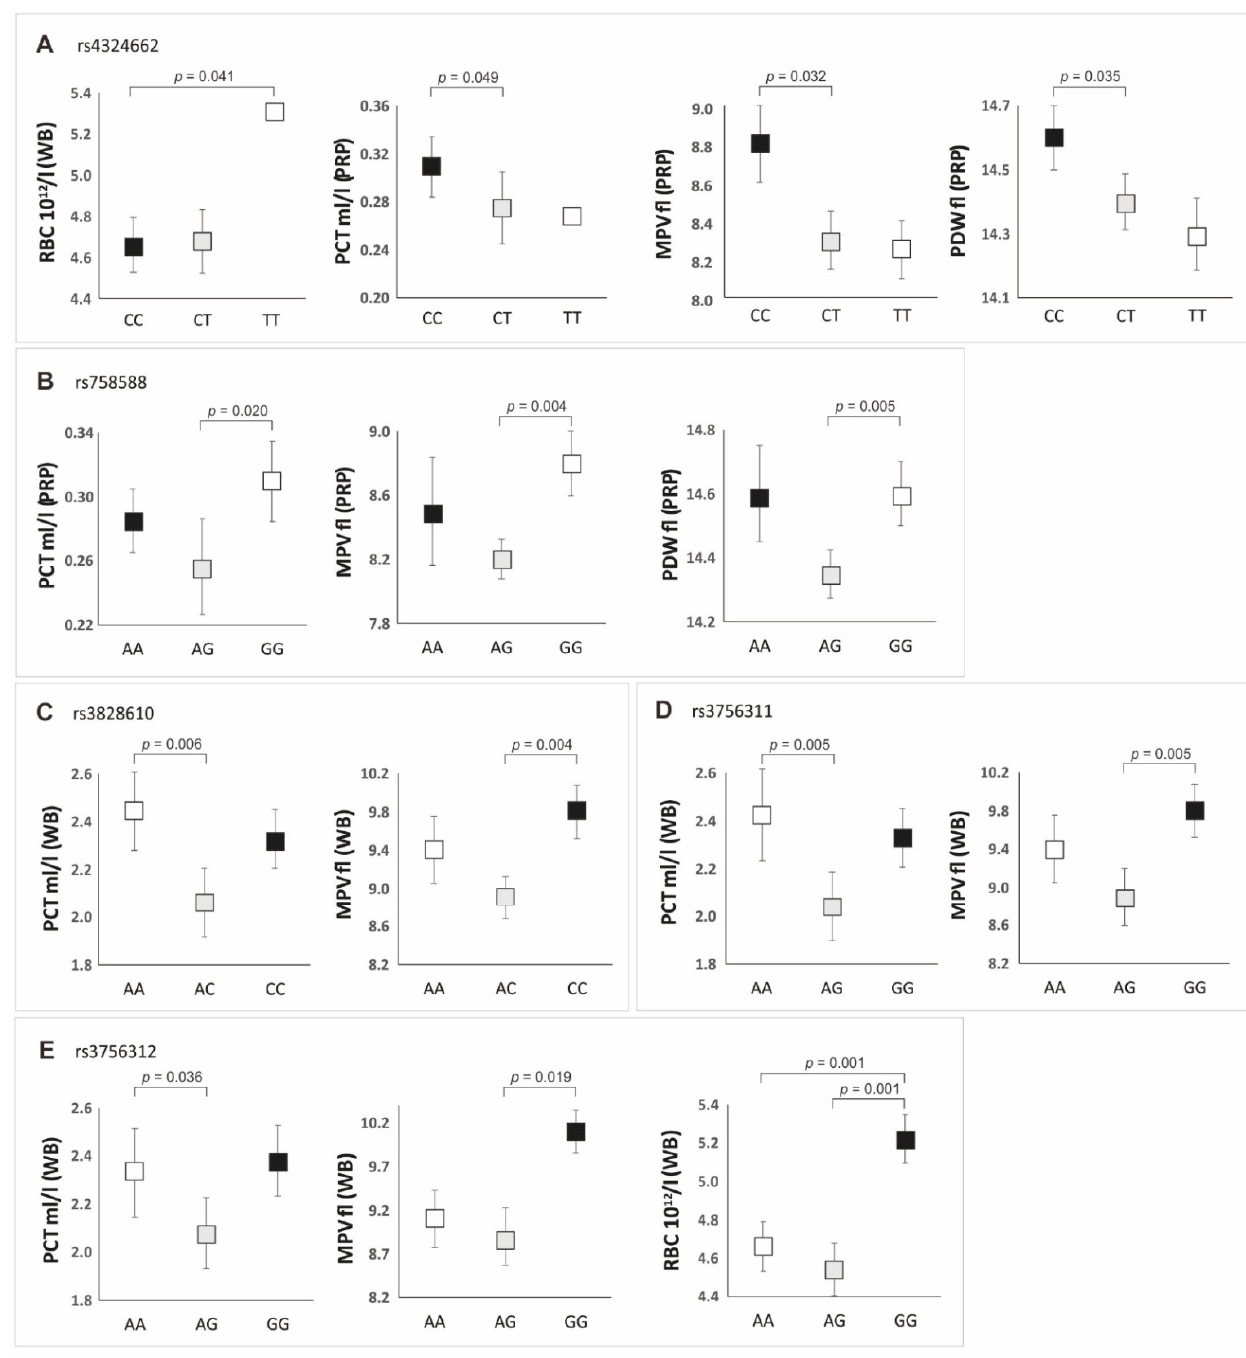
Figure 3. Whole blood (WB) and platelet-rich plasma (PRP) parameter values in individuals with particular genotypes of PDGFRB gene polymorphisms (additive model): ( A ) for rs4324662; ( B ) for rs758588; ( C ) for rs3828610; ( D ) for rs3756311; ( E ) for rs3756312 SNP. The factor that significantly differentiated particular genotypes ( p < 0.050) was, how- ever, the number of alcohol units consumed per week (Table S1). The most alcohol units were consumed by the cases with the genotype TT (rs4324662), AA (rs758588), CC (rs3828610), and GG (rs3756311 and rs3756312) (Table S1). In most cases, these patients had lower levels of PLT (in whole blood and PRP), compared to other genotypes of indi- vidual polymorphisms (Table S2). It should be noted, however, that the differences in the concentration of platelets between individual genotypes were not statistically significant